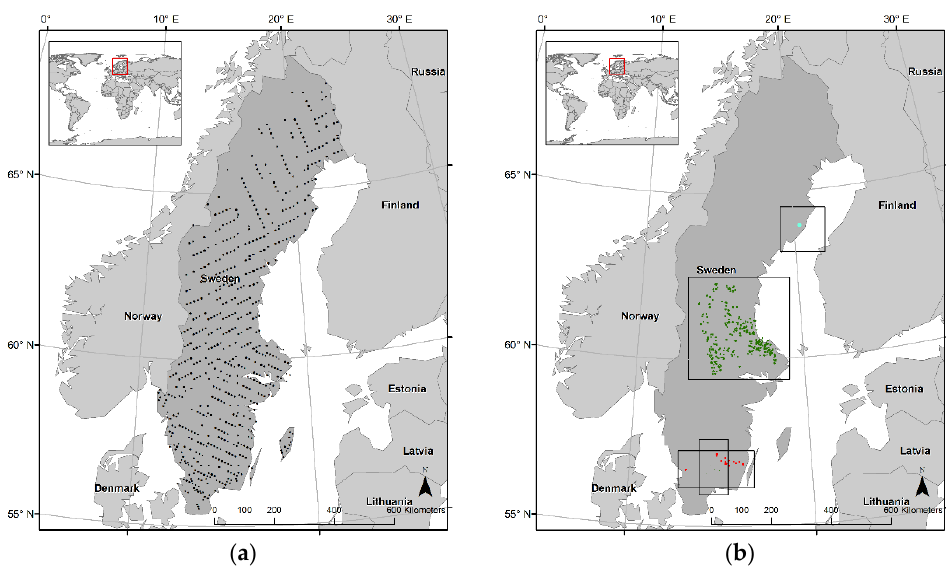
Figure 3. Coverage of Sweden with ( a ) NFI plots of 2016 used for model training and ( b ) evaluation stands from the three datasets. National maps © 1995–2017 ESRI.